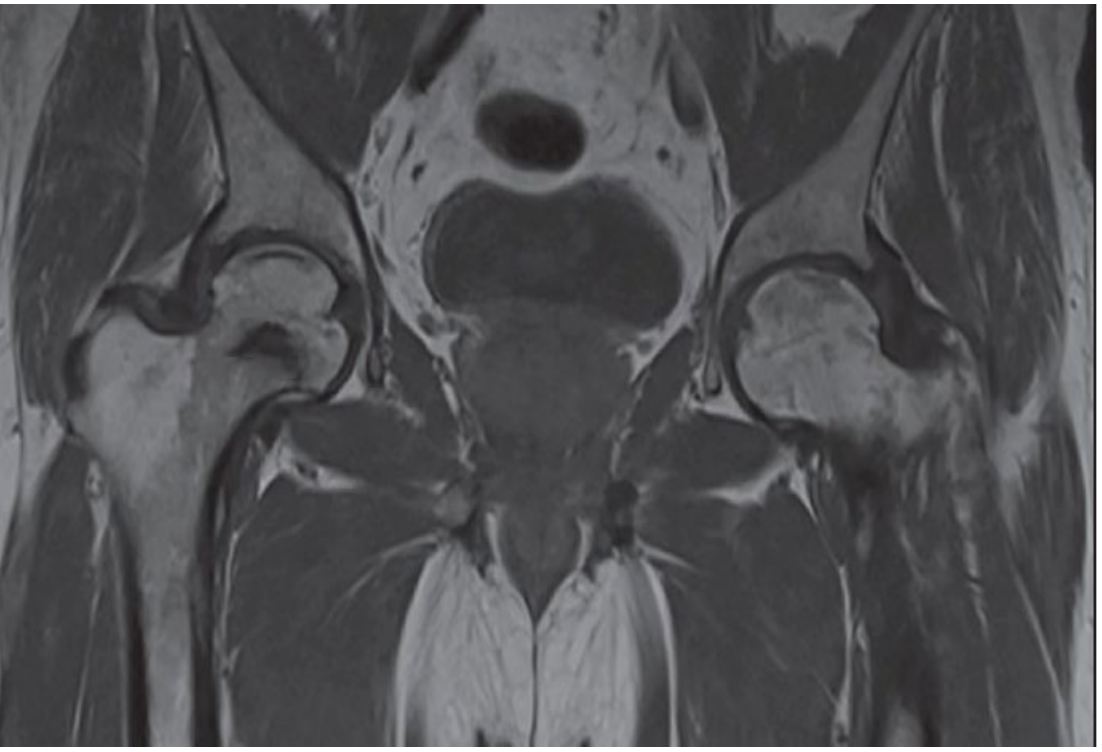
Figure 3. The posteroanterior view shows a right (R) AVN of the femoral head (T1-weighted). MRI is the gold standard for osteonecrosis diagnosis and allows differentiating AVN from other diagnoses that may mimic it, such as bone bruises or transitioned osteopenia [1,9]. MRI allows for early AVN diagnosis and may help identify patients at risk of femoral head fracture. Identification of bone marrow edema in the proximal femur and joint effusion are critical prognostic factors [3]. T1-weighted images show a limited subchondral linear- shaped low signal intensity, while T2 demonstrates a double-line sign [44]. However,